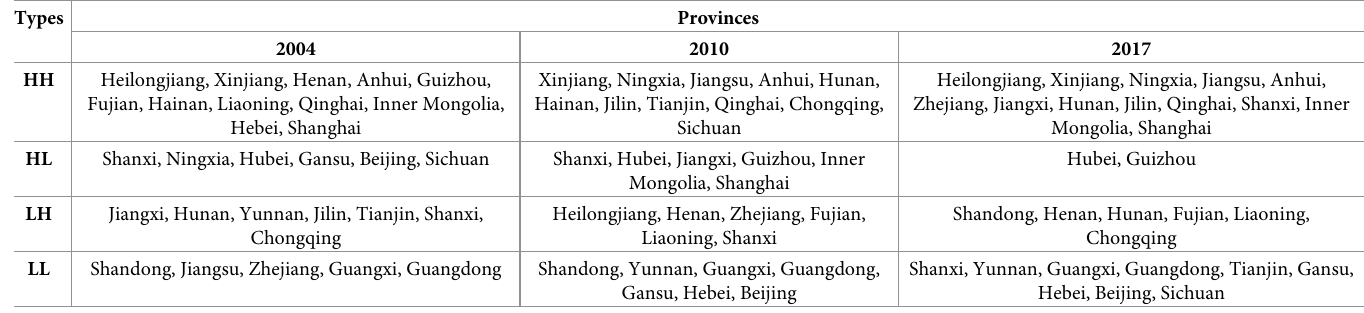
Table 6. The spatial types of China’s provincial GTFP in 2004, 2010 and